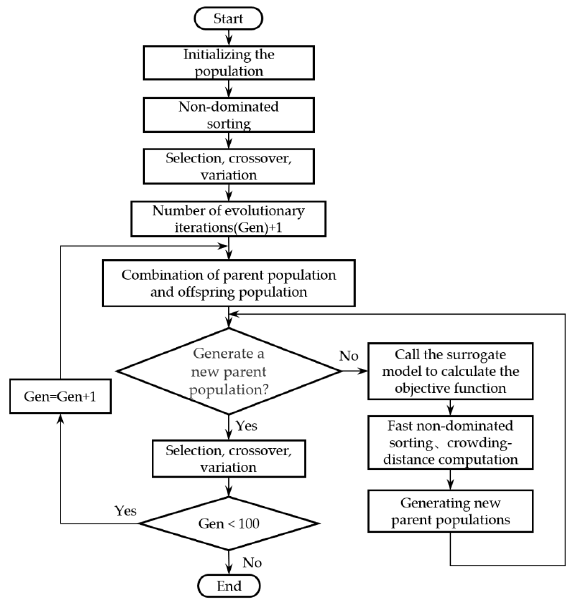
Figure 6. Optimization flowchart of NSGA-II.